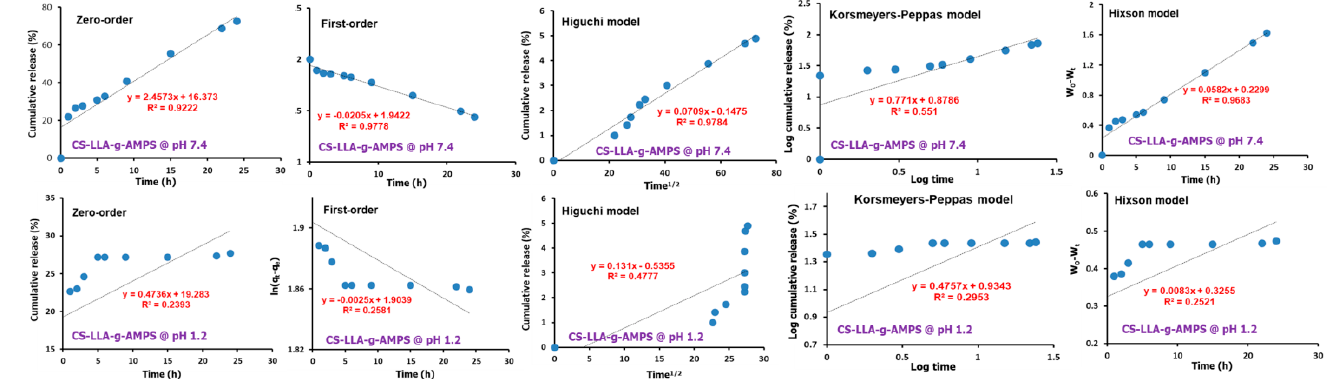
Figure 8. Kinetic studies of CS ‐ LLA ‐ g ‐ AMPS at pH 1.2 and 7.4.